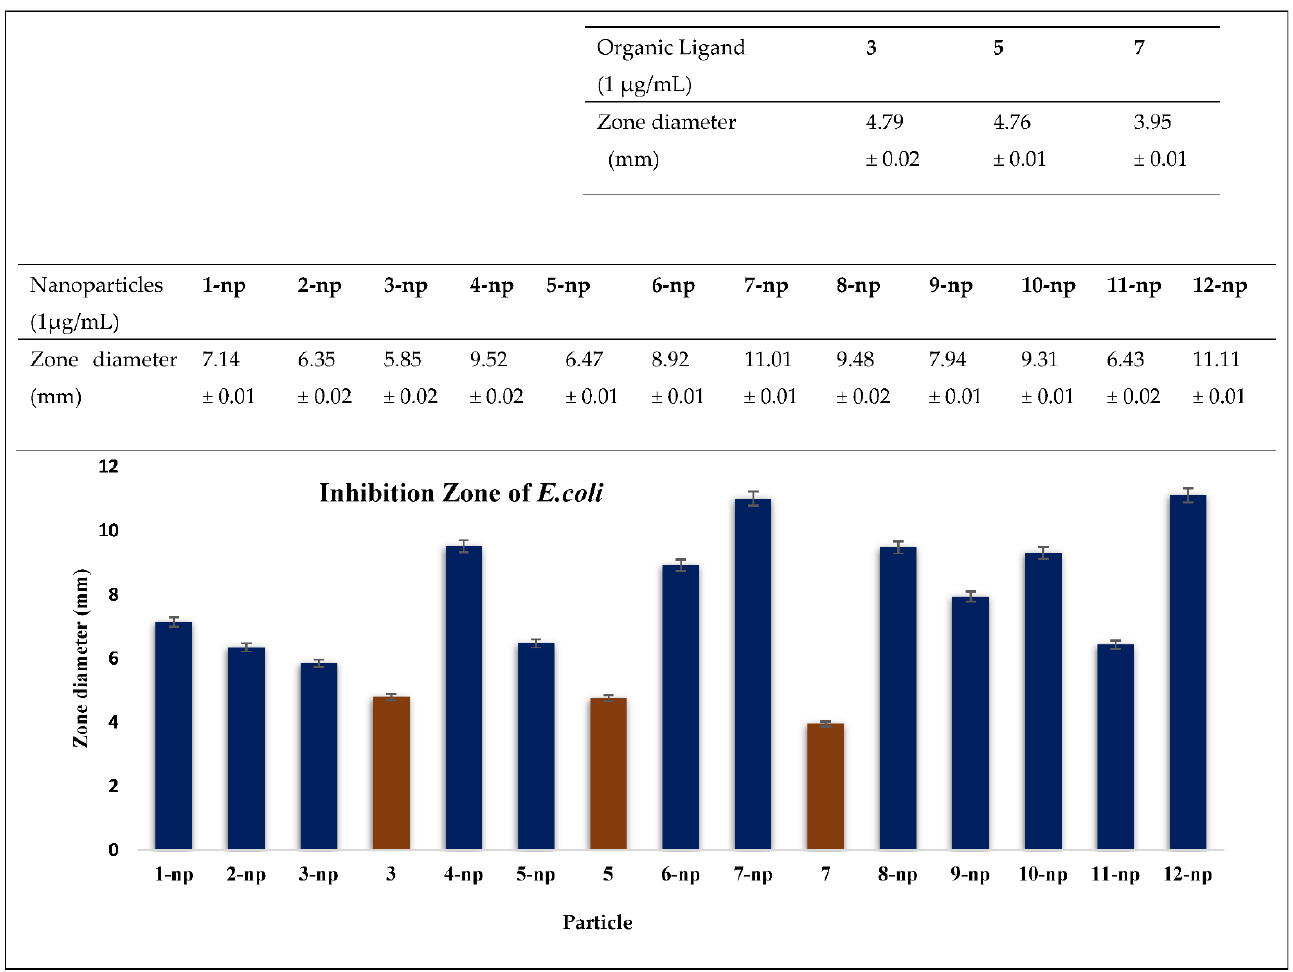
Figure 8. Representative zones of inhibition of the AgNPs with their respective organic ligands (bacterial assays were performed as triplicates and mean values are presented with ± standard